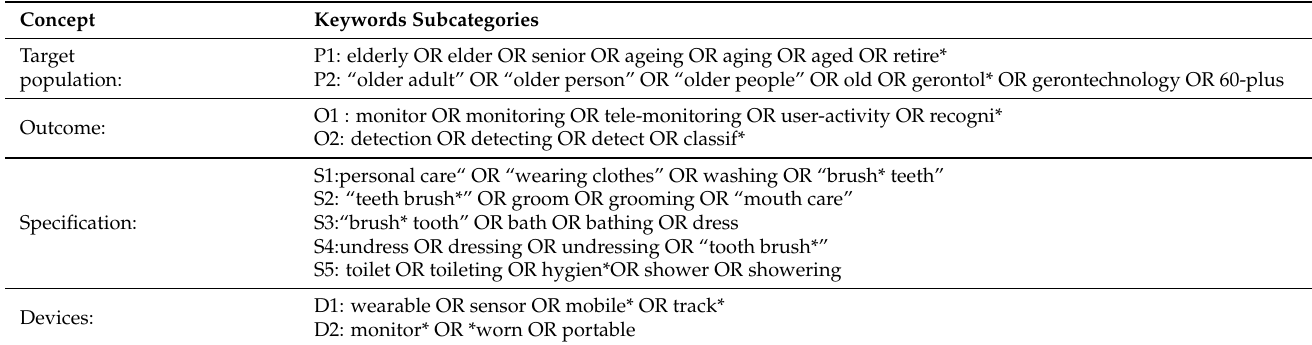
Table A1. Subcategories of Keywords applied in IEEE Explore. An asterisk (*) was used as a wildcard to broaden the search for words starting or ending with a keyword.